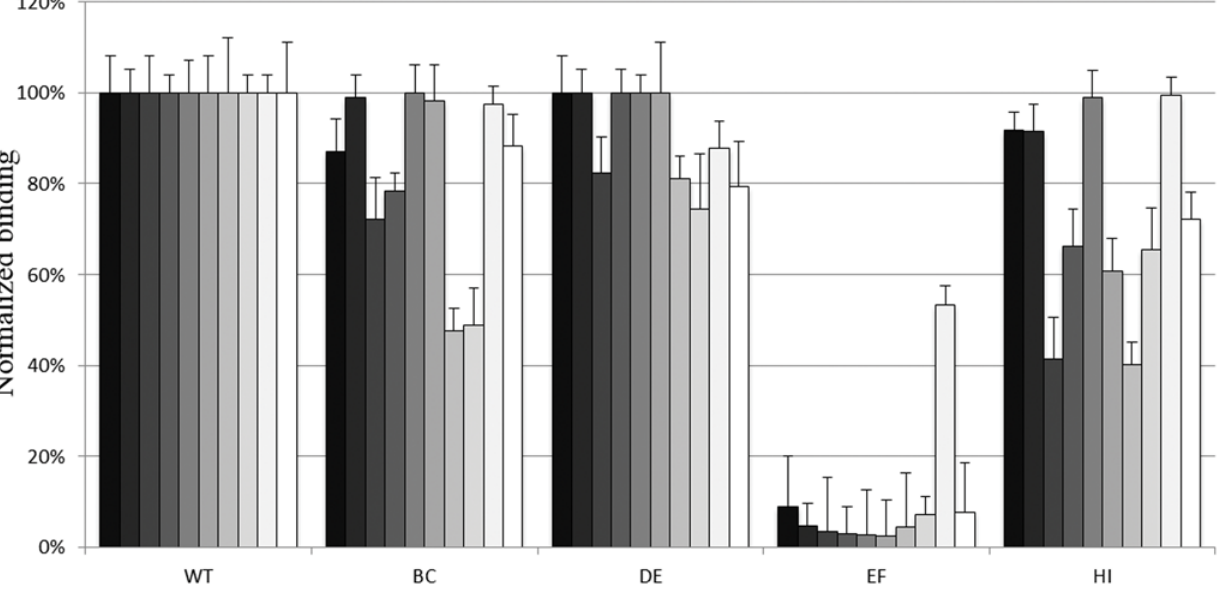
Fig 4. ELISA reactivity of 10 neutralizing anti-MCPyV positive human sera (MCC patients) against MCPyV insertional mutants BC, DE, EF and HI. In order to characterize the epitopes of the MCPyV VP1, the reactivity of the human sera was analyzed from ten patients using the MCPyV wt VP1 VLPs and the four mutants with insertion within the BC, DE, EF and HI VP1 loops. ELISAs were performed using neutralizing anti-MCPyV positive human sera diluted 1:1000. The results are presented as relative binding defined as the reactivity of human serum to mutant VLPs divided by the reactivity of the same human serum observed with wild-type VLPs. The data presented are the means of three determinations (+/- SEM).